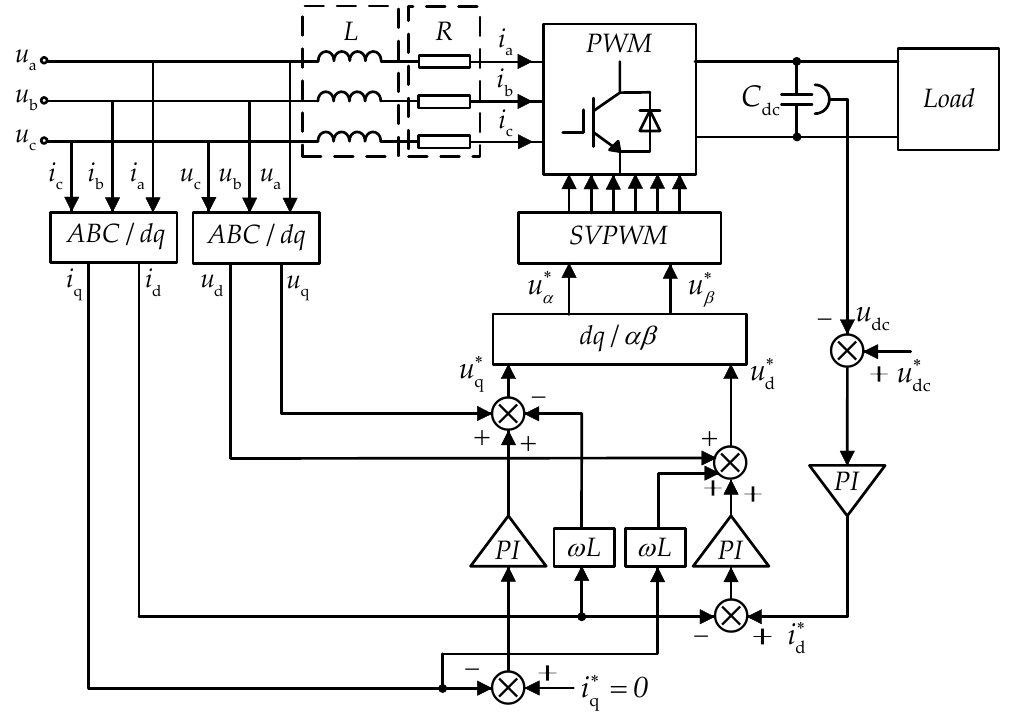
Figure 3. Control block of three-phase PWM converter.